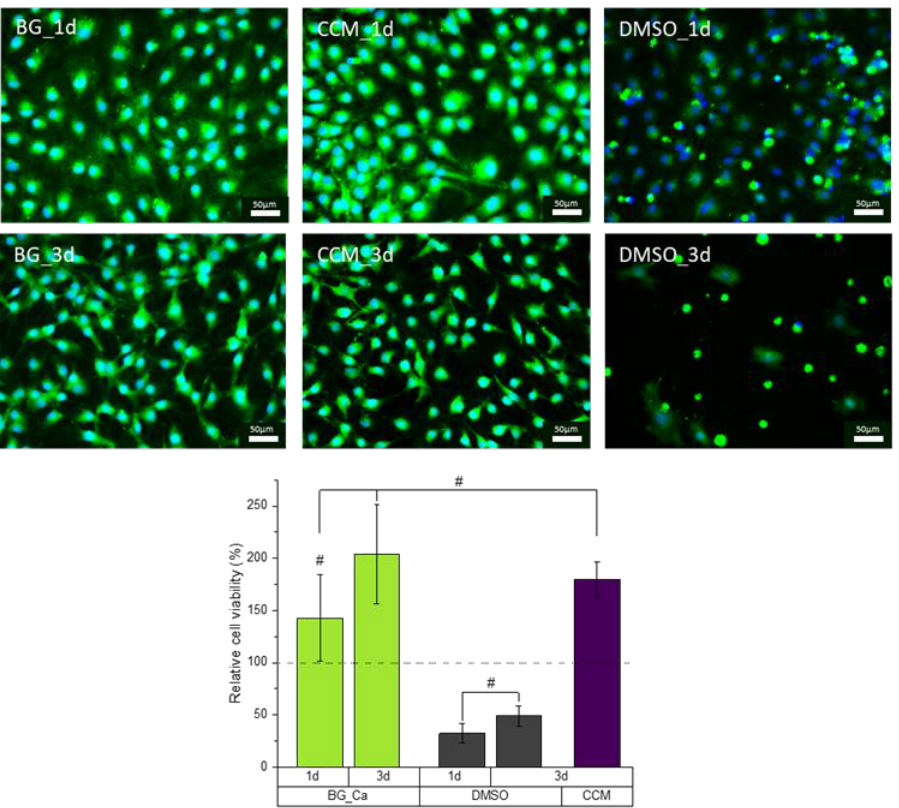
Figure 10. Fluorescence images of living cells (green) and cell nuclei (blue) of MC3T3-E1 cells cultured for 1 ( top ) and 3 ( middle ) days in CCM (positive control), 6% DMSO (negative control) and conditioned CCM of composites containing 30 w/v % BG. Relative cell viability (WST-8) of MC3T3-E1 cells ( bottom ) cultured for 1 and 3 days. Statistical analysis using one-way ANOVA indicated a significant difference ( p < 0.05) for all samples. Samples labeled with # are found to be an exception.